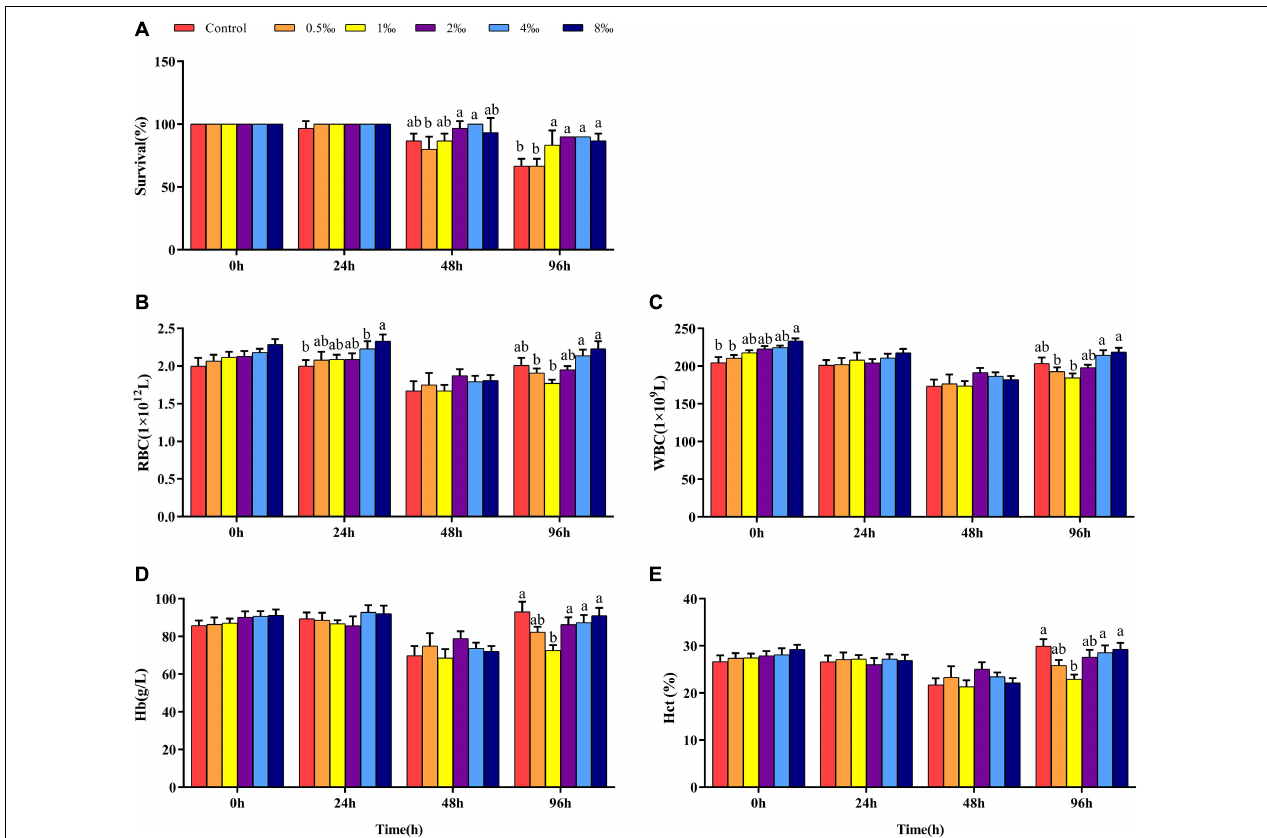
FIGURE 1 | Survival and blood parameters of genetically improved farmed tilapia (GIFT) infected with Streptococcus iniae after being fed different Acanthopanax senticosus (APS) levels. (A–E) Represent the control, 0.5, 1, 2, 4, and 8 APS supplementation treatments, respectively. Different lowercase letters show significant differences among different treatments at each sampling point (Duncan’s multiple range test; P < (cid:104)